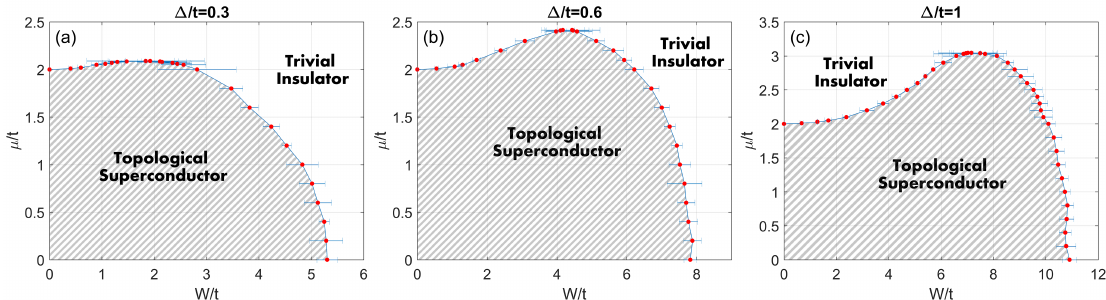
Figure 4. Phase diagram as a function of the disorder strength W / t and the chemical potential µ / t for three values of ∆ : ( a ) ∆ / t = 0.3, ( b ) ∆ / t = 0.6, ( c ) ∆ / t = 1. The hatched region is the topological superconductor phase, the other region is topologically